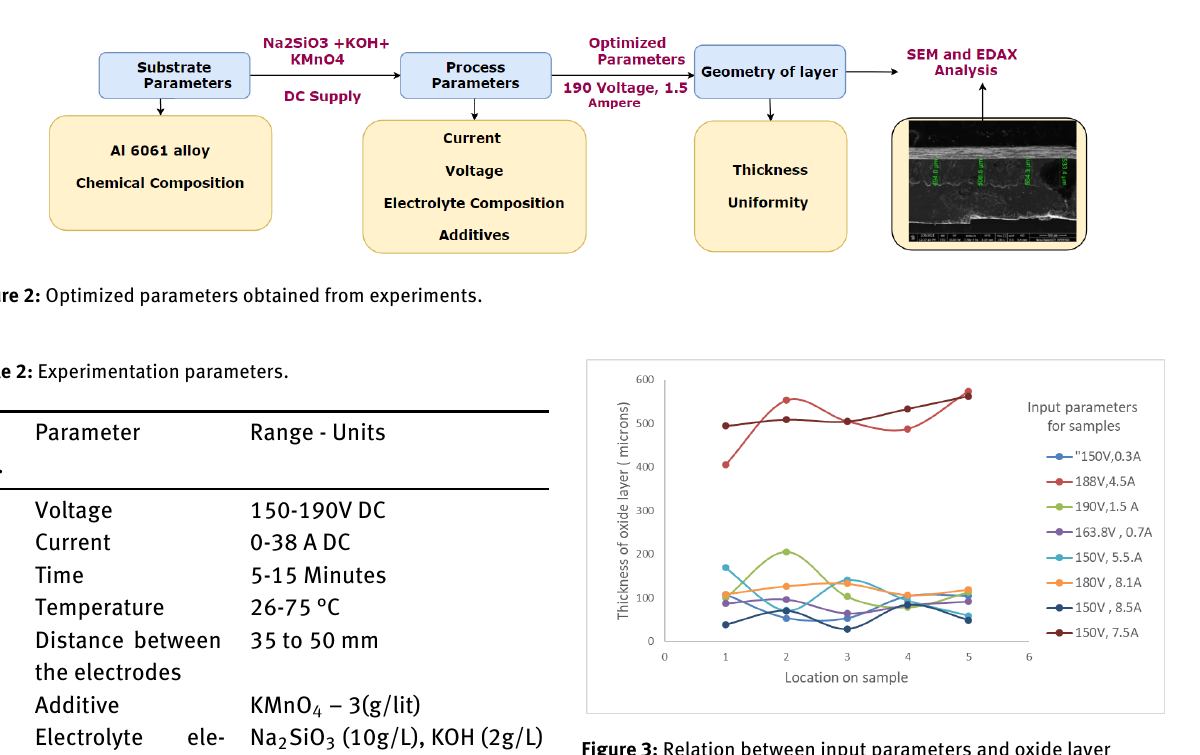
Figure 3: Relation between input parameters and oxide layer